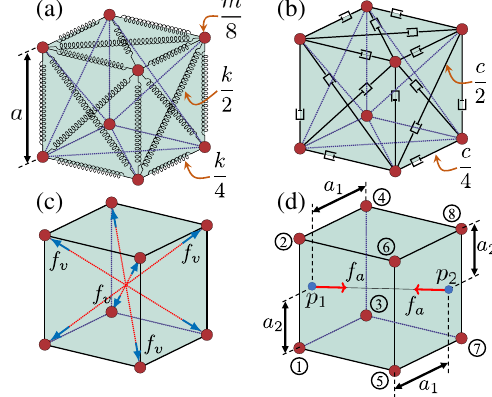
FIG. 1. A cubical element of the MSM. (a) The mass of the cube m is distributed equally among the eight cubes that meet at one corner. The edge and diagonal springs have a stiffness of k= 4 and k= 2 , respectively. (b) A Kelvin-Voigt-type damping system is used where the edge and diagonal dampers have a damping constant of c= 4 and c= 2 , respectively. (c) To add volume conservation to the model, a penalty pressure is applied to the faces of the cube. This pressure results in forces at each corner. (d) The compressive active contraction is applied along the fiber direction in each cube, and, based on the distances a 1 and a 2 with bilinear interpolation, it is redistributed on the